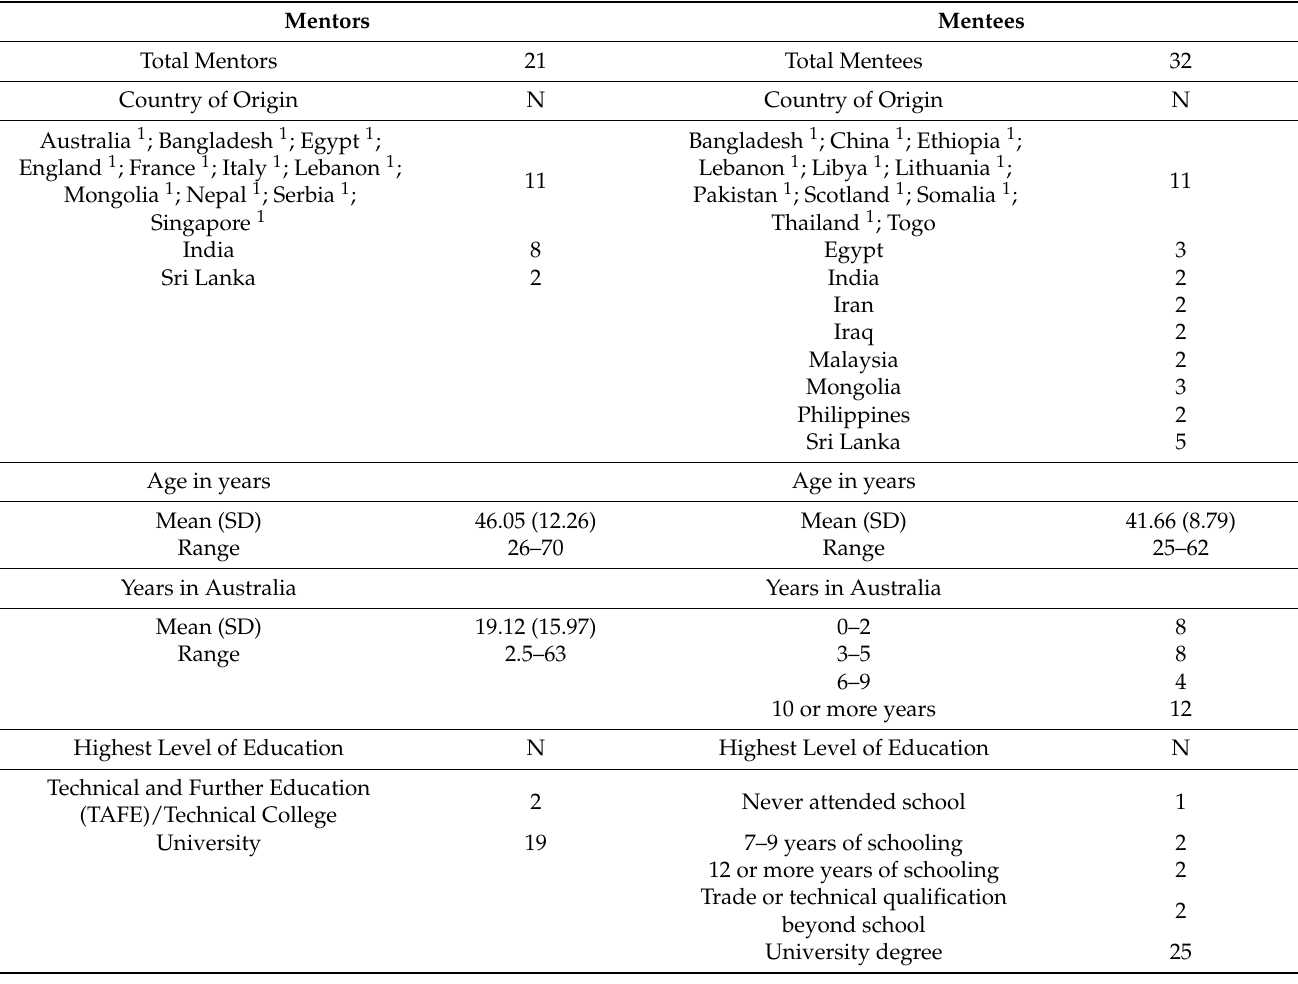
Table 2. Characteristics of